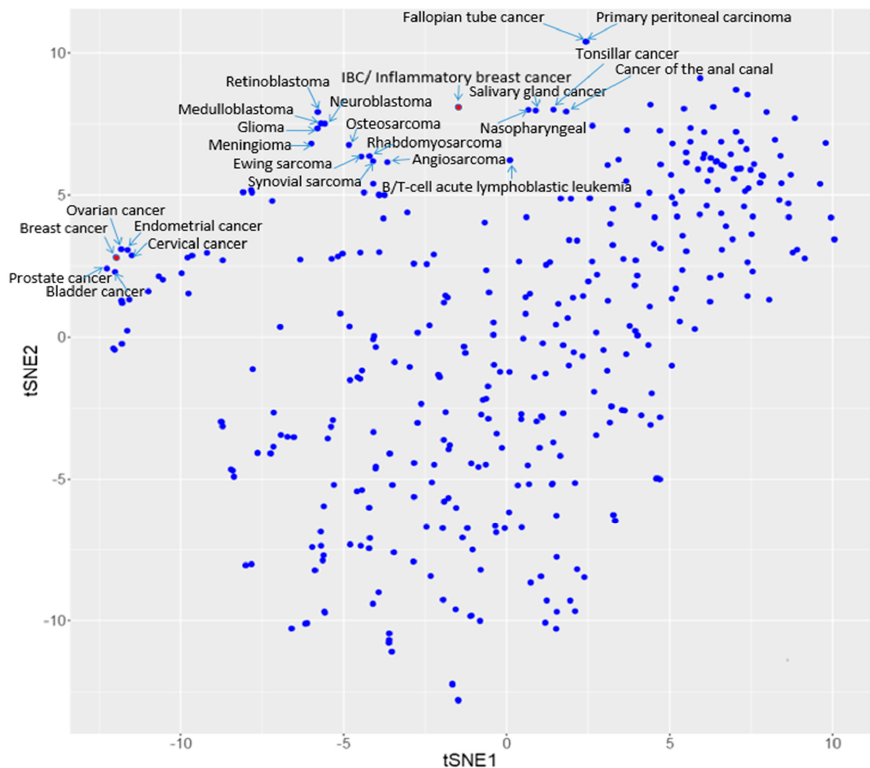
Figure 3. Diseases clustered with IBC and breast cancer, respectively, on the disease similarity map. Table 1. Diseases clustered close to IBC and their corresponding drugs.